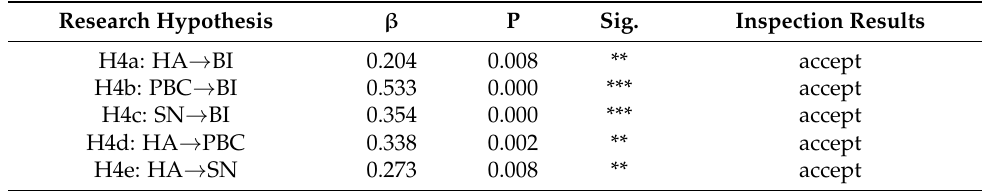
Table 7. Hypothesis test results of structural equation model.